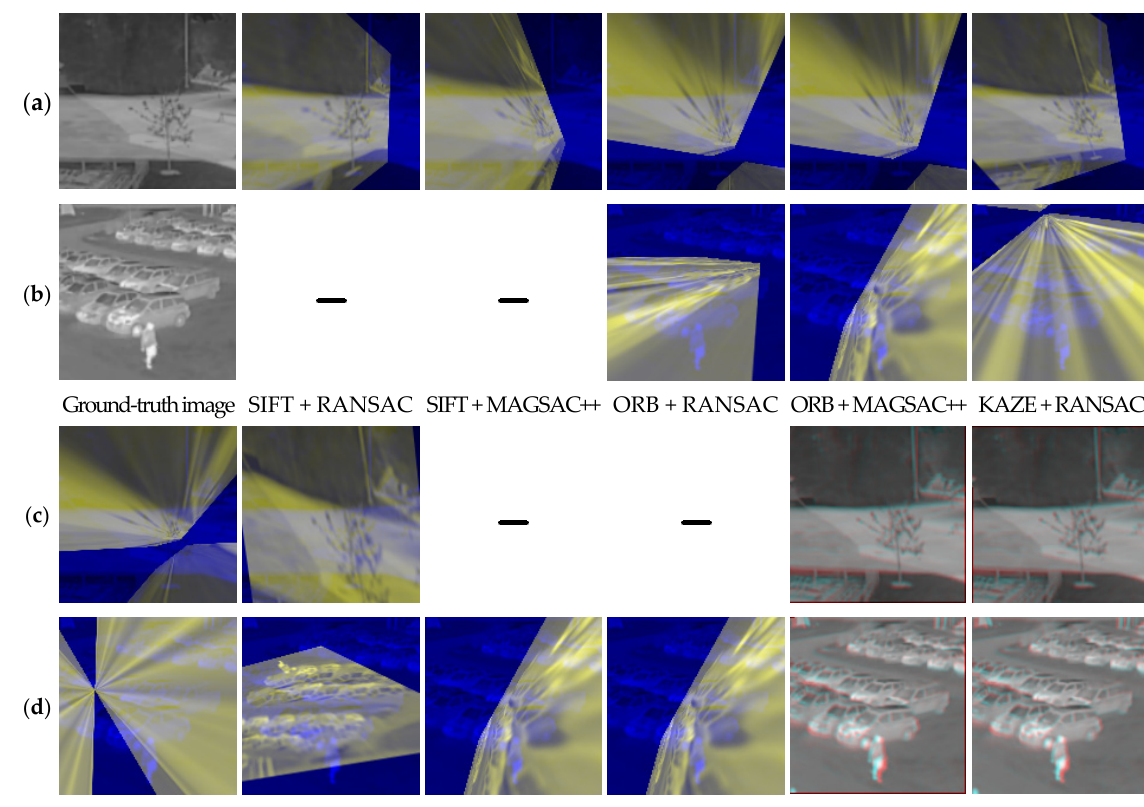
Figure 9. Comparison of channel mixing results of warped images and ground-truth images in two examples, as shown in ( a – d ).